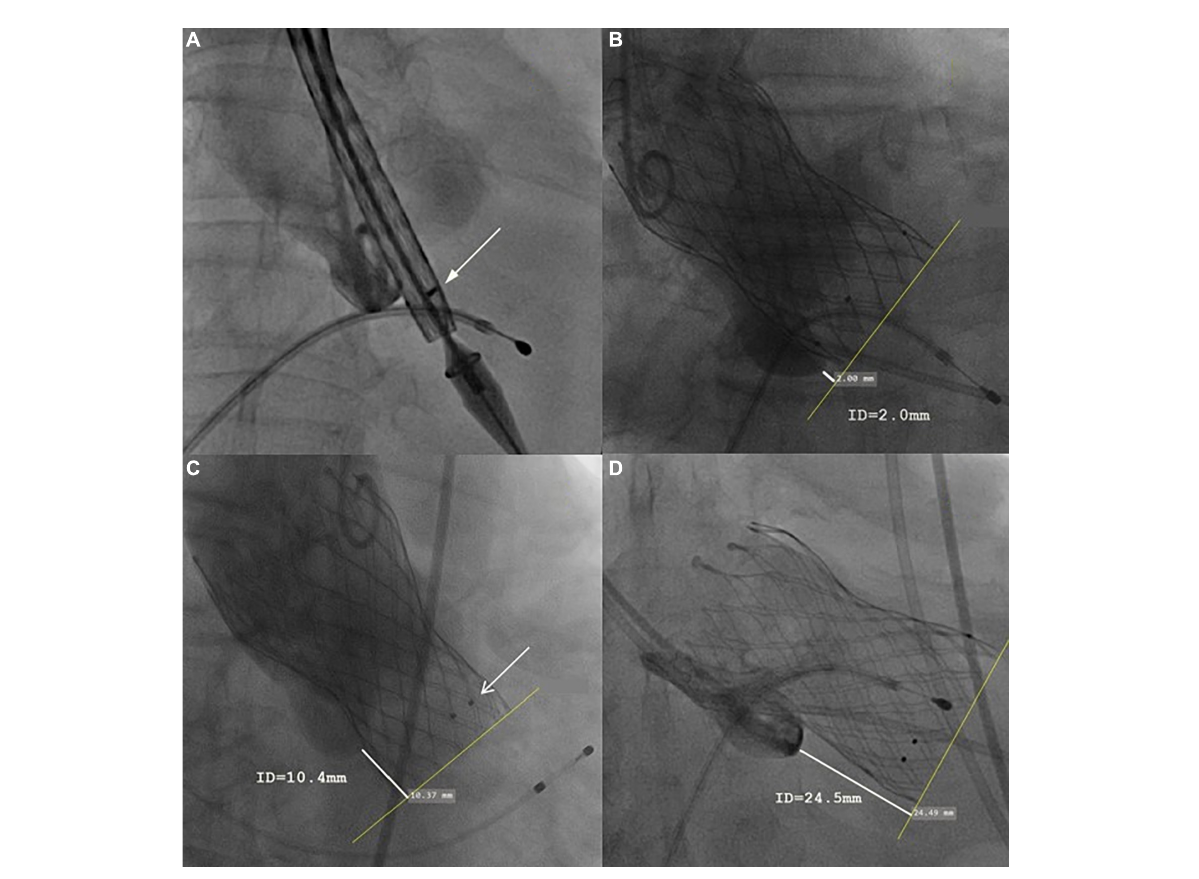
FIGURE1 Representative case of each group. (A) The initial position of the prosthesis. (B) In optimal implantation, the implantation depth (measured as the distance from the native aortic annulus plane on the side of the non-coronary cusp to the most proximal edge of the implanted prosthesis) was 2.4 mm. (C) In the mild malposition case, the implantation depth was 10.4 mm, no perivalvular leakage or residual stenosis was found. The three black dots indicated by the white arrow were 5 mm from the proximal edge. (D) In severe malposition cases, the prosthesis migrated toward the ventricular direction during release, causing very deep implantation (implantation depth = 24.5 mm). Severe residual regurgitation was found and then a second Venus-A Valve was implanted (valve-in-valve